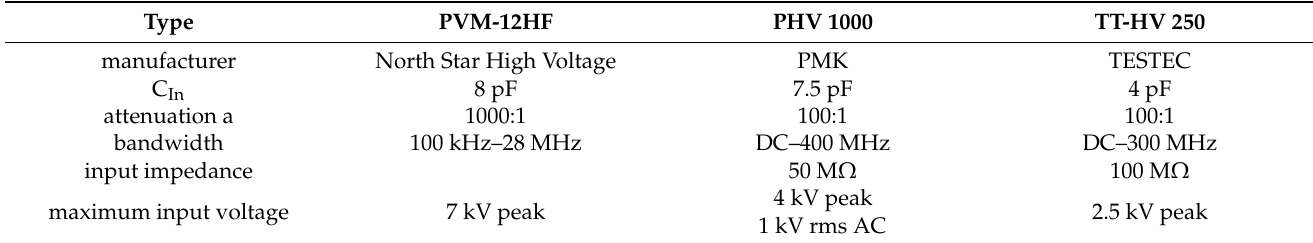
Table 3. Comparison of three different commercially available high-voltage